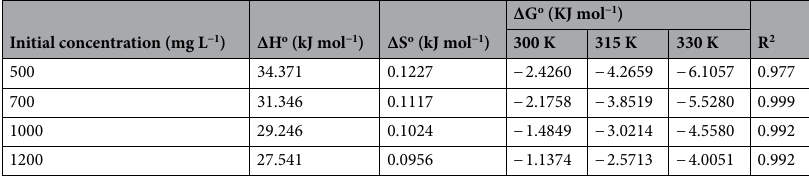
Initial concentration (mg L −1